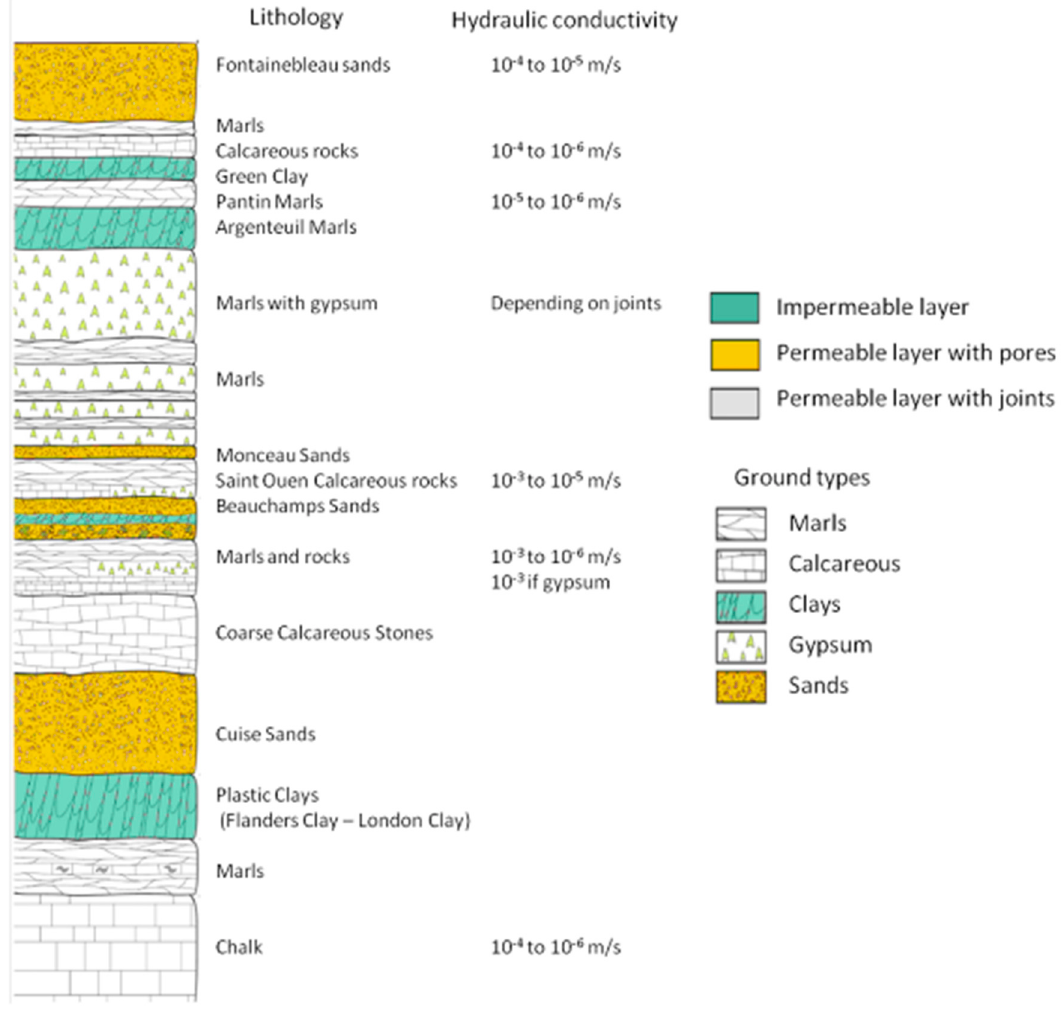
Figure 3. Geological and hydrogeological context of the Paris region (translated from an internal report of Cerema, not referenced).